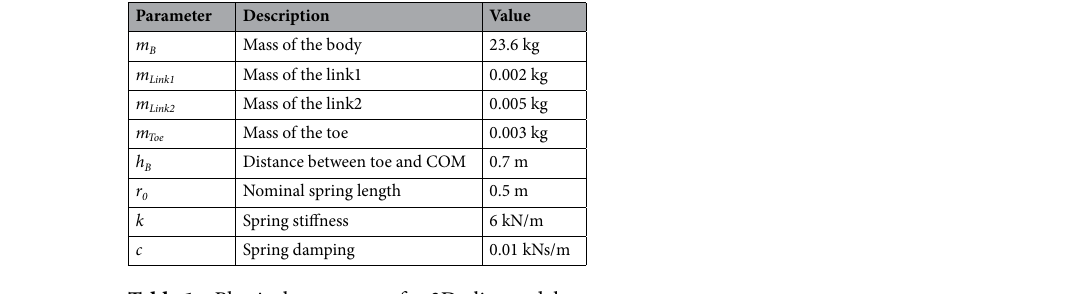
Table 1. Physical parameters for 3D-slip